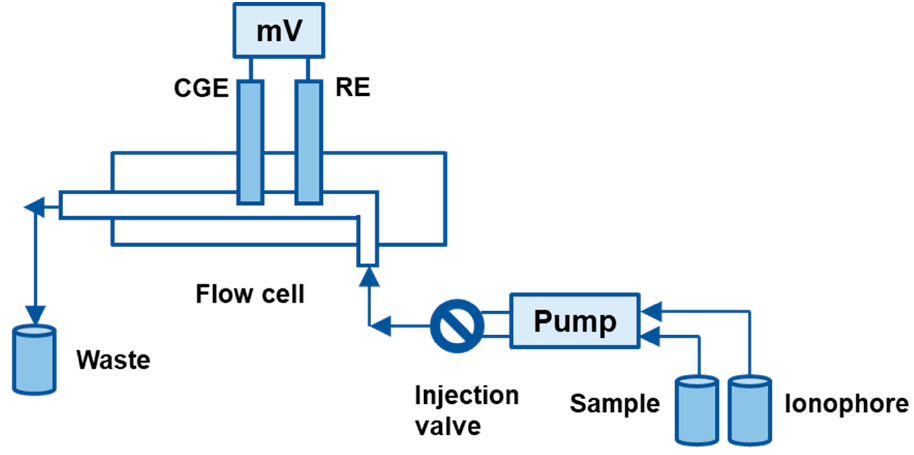
Figure 3. Manifold of the flow injection potentiometric system.